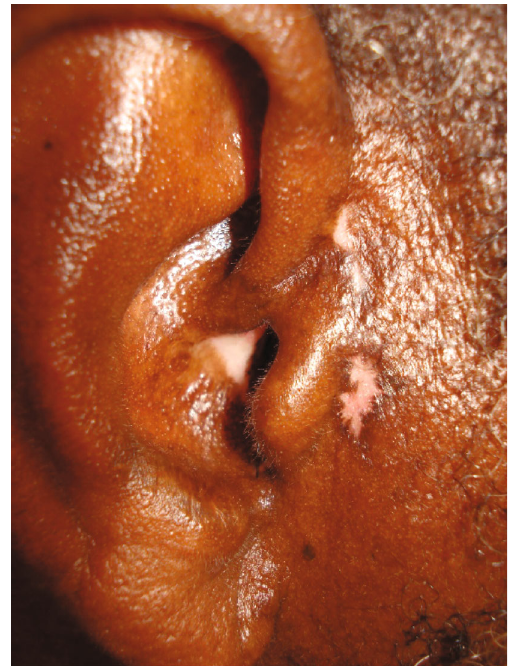
Figure 7: Hypopigmented small plaques with border of hyperpigmentation on the right preauricular